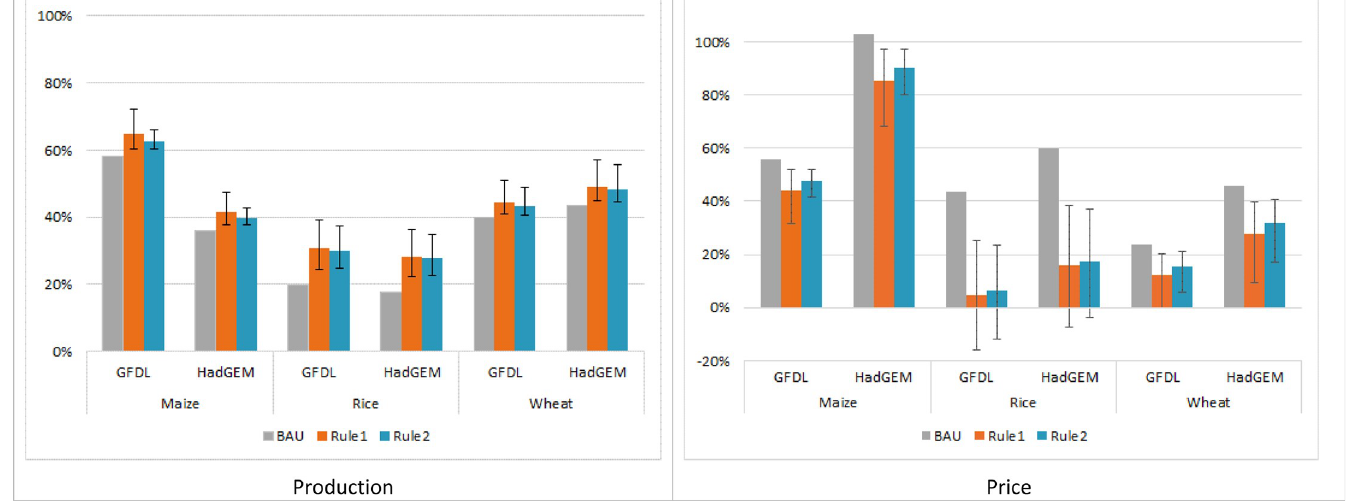
Fig 2. Percent change in production (total output) and prices comparing years 2010 and 2050 for BAU and CSA adoption scenarios. Columns indicate the average tailoring of CSA practices; whisker bars identify results for the poor and optimal tailoring. Source: Authors. BAU = business as usual scenario.